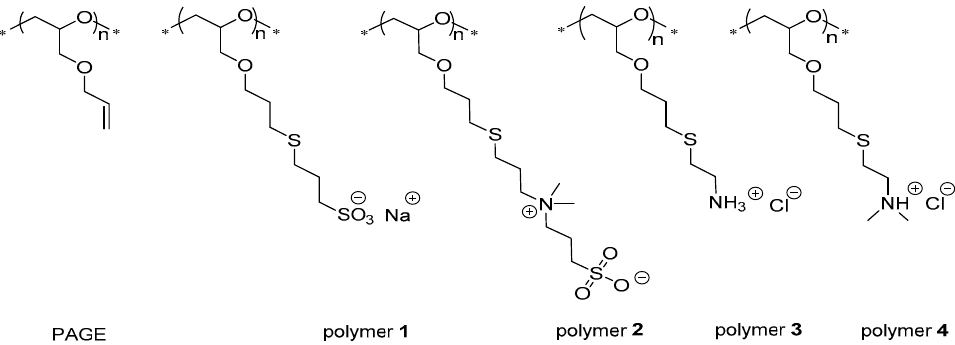
Figure 1. Chemical structure of the precursor poly(allyl glycidyl ether) (PAGE) from which the linear model polyelectrolytes 1 – 4 have been synthesized for investigation in this work (* denotes unspecified polymer end group).